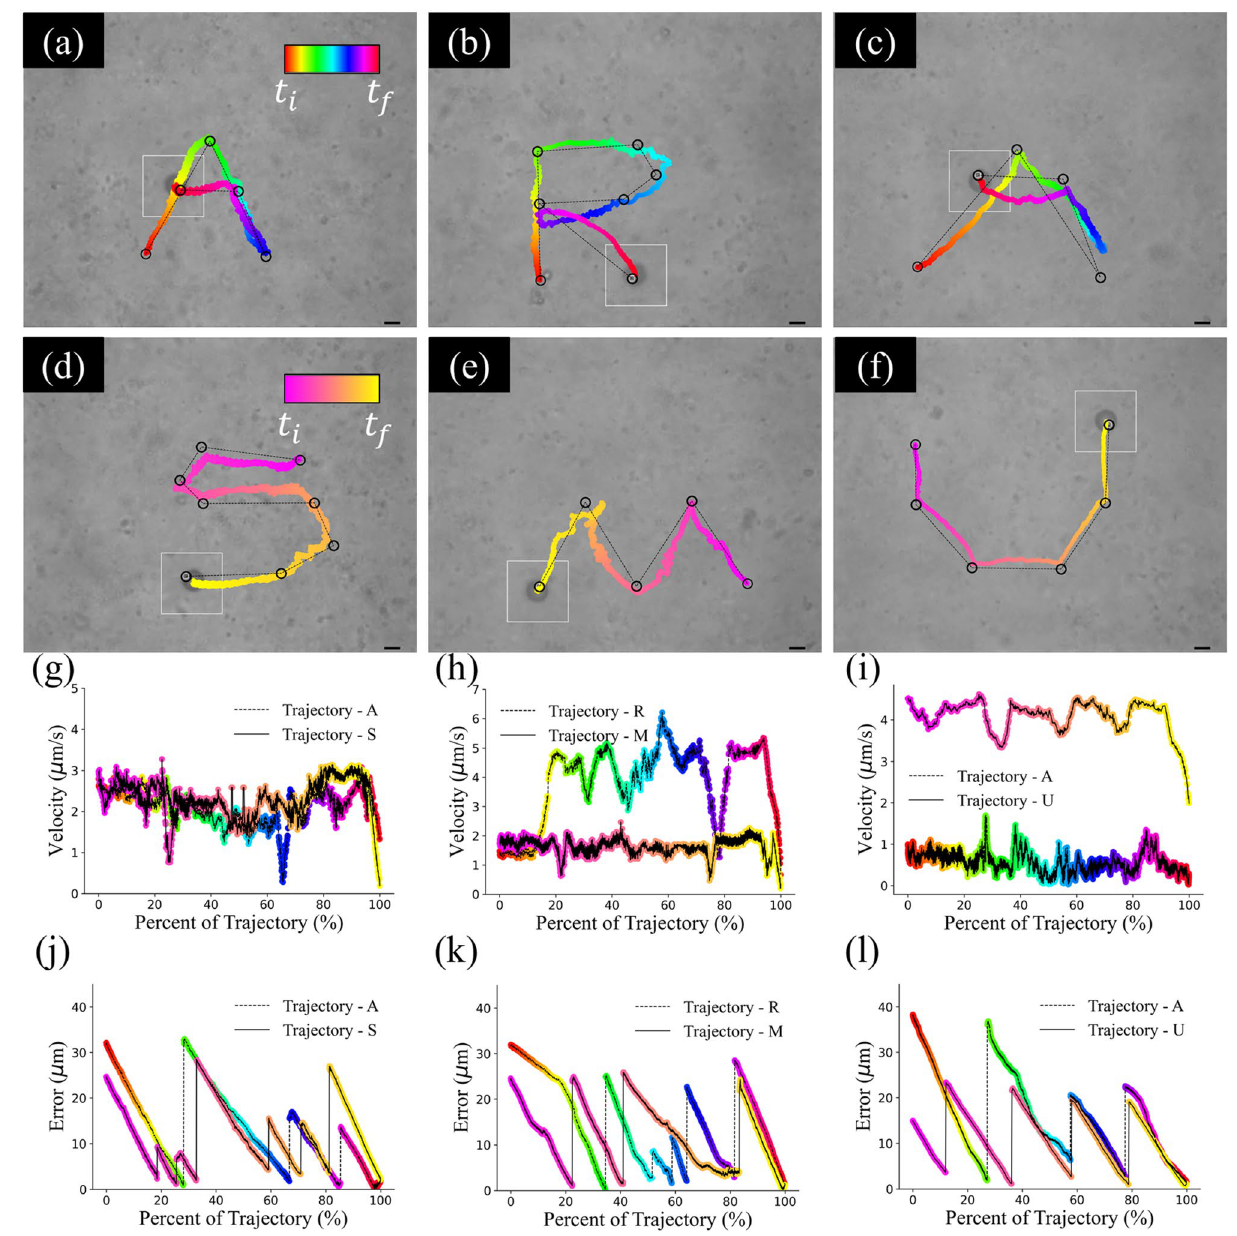
Figure 5. Trajectories of different chemically coated microparticles. Subfigures ( a , d ) represent a biotin coated microparticle, ( b , e ) represent biotin chitosan coated microparticles, and ( c , f ) represent Biotin-PEG3-amine coated microparticles. Subfigures ( g – i ) represent velocity graphs for the biotin, biotin chitosan, and Biotin- PEG3-amine microparticles, respectively. Subfigures ( j – l ) represent error in microns from each target location over time for each trajectory; sudden jumps in error indicate when a new target location was selected. Black circles represent target locations, while the dashed black line represents shortest path between individual target points. Black scale bar is 10 microns. Velocity graphs are shown as total velocity including x- and y- components. Trajectories in ( a ) and ( d ) are the same particle, while ( b , e ) and ( c , f ) were all performed by different microparticles. Timings for each trajectory were: ( a ) 62 s, ( b ) 95 s, ( c ) 269 s, ( d ) 71 s, ( e ) 74 s, and ( f ) 70 s. White box around each microparticle represents a bounding box for tracking the microparticle’s centroid. Velocity graphs were smoothed with a 60-point moving average and outliers beyond 3 × the mean of the velocity were set to the mean velocity value for each respective